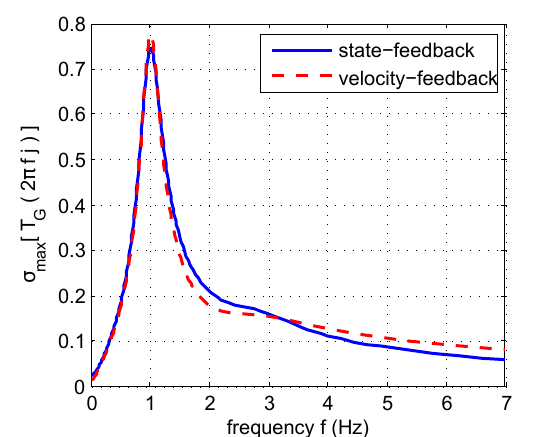
Figure 12: Decentralized velocity-feedback controller with L = L ( d ) . Maximum singular values δ ∗ ,µ ∗ of the closed-loop pulse transfer functions corresponding to the decentralized velocity- feedback controller u ( t ) = (cid:101) K ( d ) y ( t ) (red dashed line) and the optimal state-feedback controller u ( t ) = (cid:101) G s x ( t ) (blue solid line) given in eqs. (93) and (94). As a result, we obtain the diagonal velocity gain matrix (cid:98) K ( d ) = 10 6 ×     